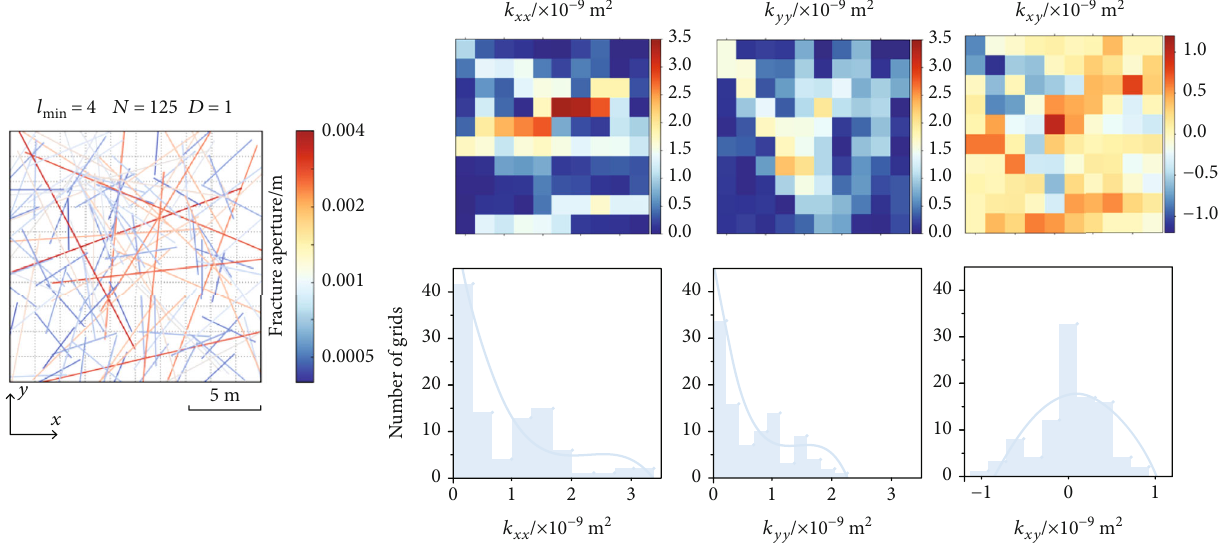
Figure 5: (a) Cartesian grid for the discrete fracture model, (b – d) spatial distributions, and (e – g) histograms for equivalent permeability components based on